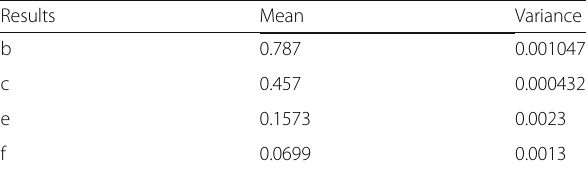
Table 3 Comparison of different results Results